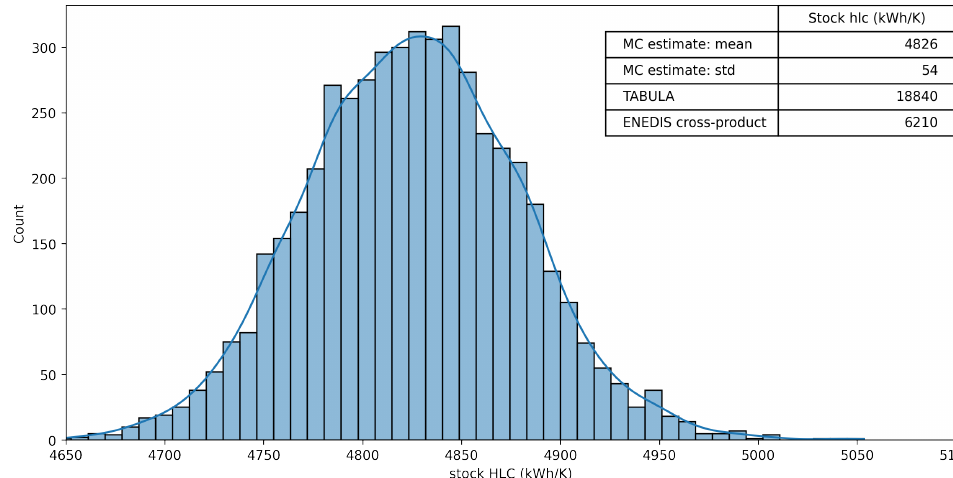
Figure 20. Monte-Carlo simulation for TABULA french